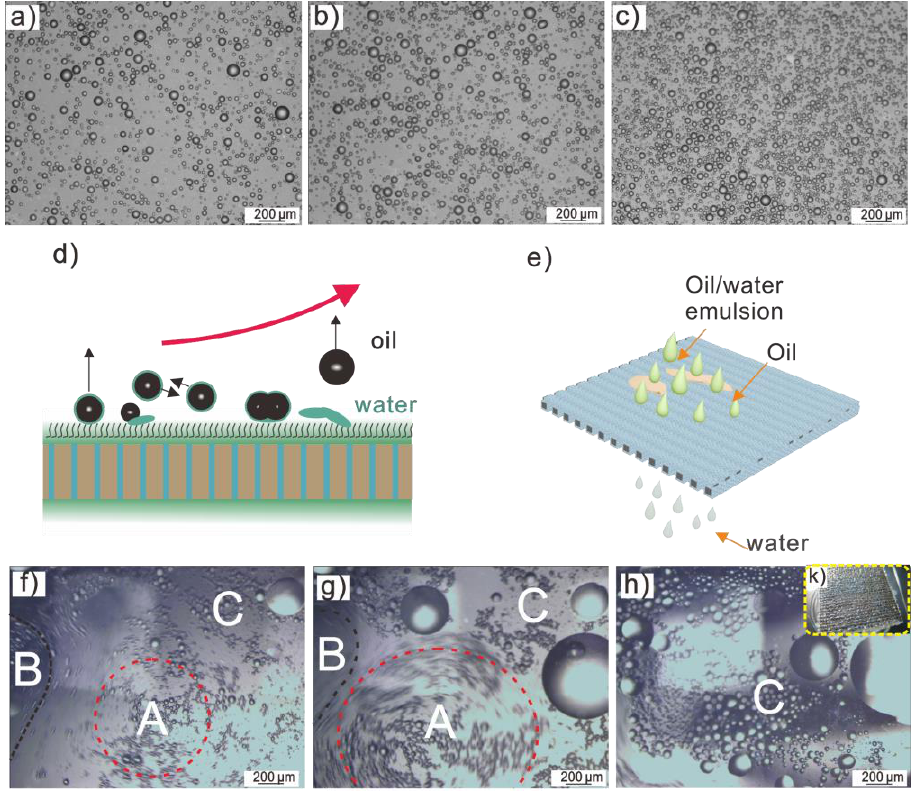
Figure 4. Optical microscopy images of oil-in-water emulsion demulsification and separation. ( a – c ) Showing oil demulsification and condensation process of AlCl 3 . ( d , e ) A scheme of synchronous demulsification and separation process. ( f – h ) Optical microscopy of separation process with water permeating through S-USM, leaving oil droplets above the mesh. ( k ) Optical imagines of milky emulsion on S-USM after